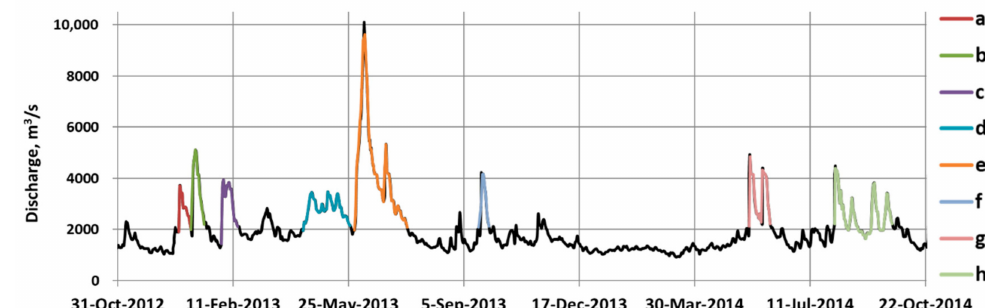
Figure 3. Discharge time series at rkm 1801 for the period October 2012–October 2014. The di ff erent